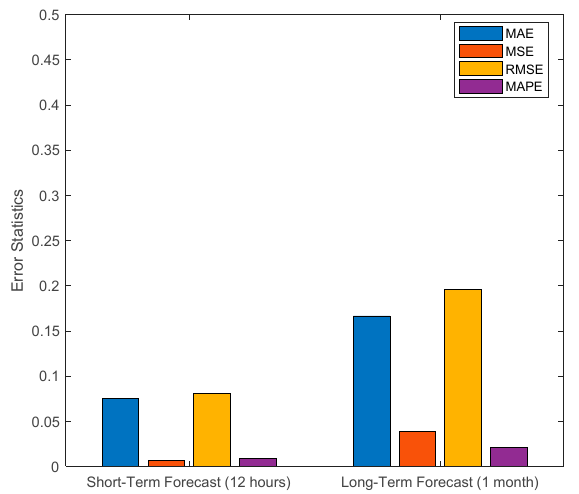
Figure 8. Long-term forecast result measured against actual DO concentration values.